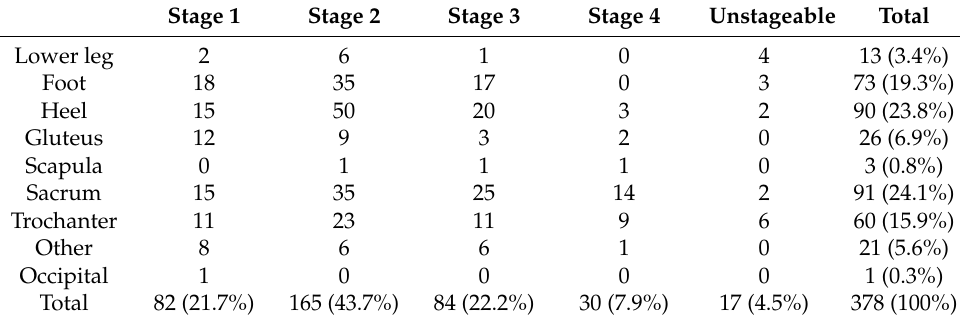
Table 5. Pressure injury stage and location.